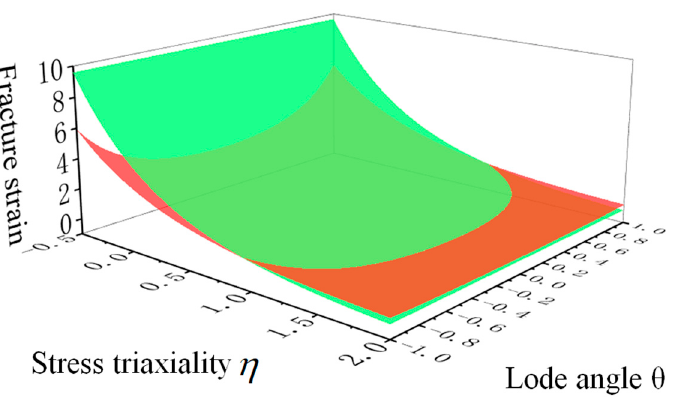
Figure 13. Comparison of the ductility of two fracture criteria under principal stress state region.